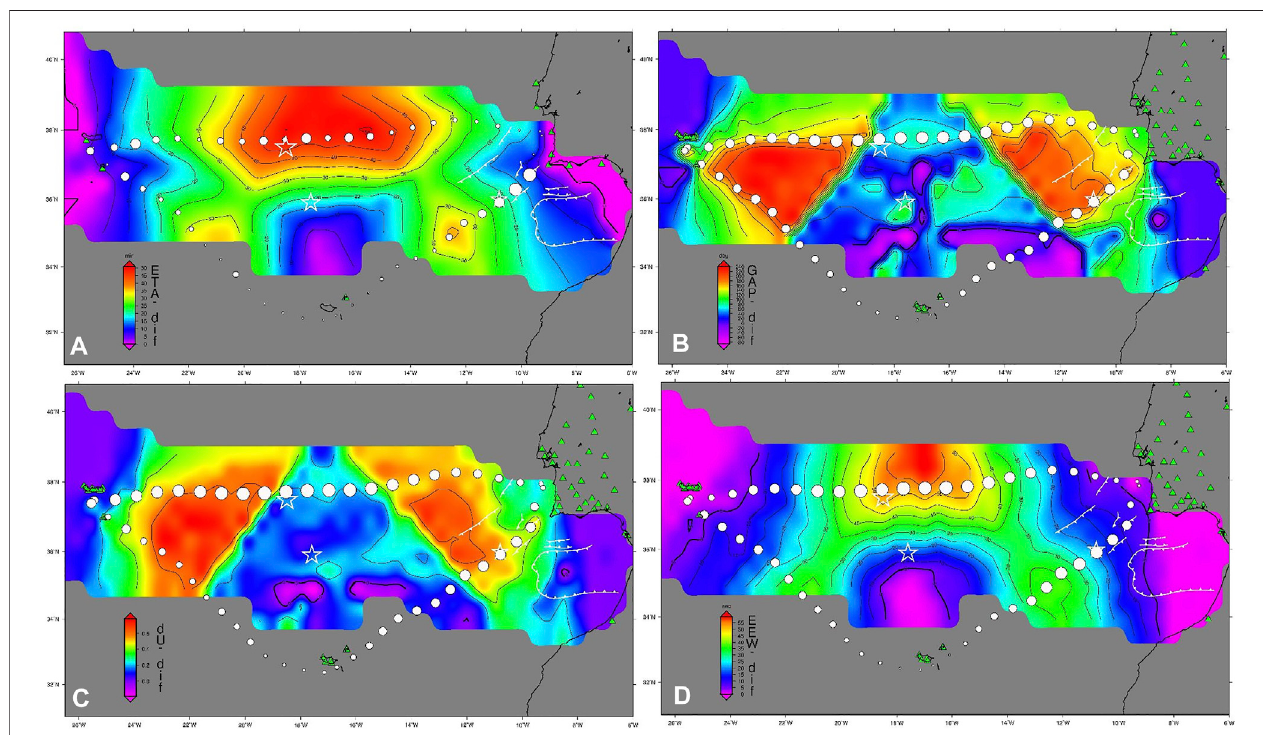
FIGURE15|(A) Reductionintsunamiarrivaltime(minutes)obtainedbytheCAM-2setofsensors(whitecircles)whencomparedtothecoastaltidegaugenetwork monitored by IPMA (green triangles). (B) Comparative reduction in azimuthal gap (degrees). (C) Improvement in the network quality metric. (D) Reduction in earthquake earlywarningtime(EEWinseconds)obtainedbytheCAM-2setofsensorswhencomparedtotheseismiclandnetworkmonitoredbyIPMA.Thesizeofthecablesensor symbols is proportional to the number of events used. Purple area de fi nes where the CAM-2 sensors did not improve the result. White stars show the location of 3 M > 7.7 20th century earthquakes that caused small tsunamis. The location of the November 1, 1755 earthquake is uncertain, and we show the tectonic faults (white lines) that are suggested to be at the source of that event by several